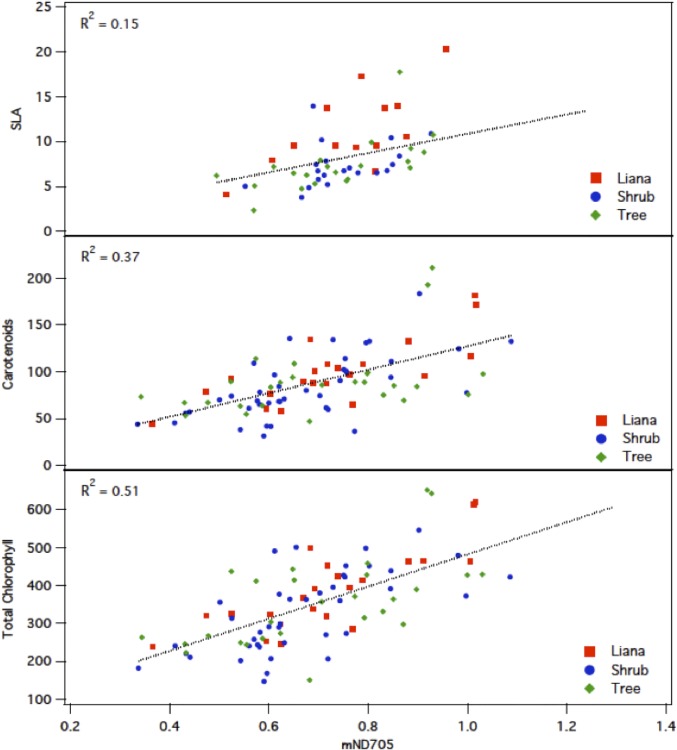
Relationships between and modified NDVI at 705nm (mND705) and Specific Leaf Area (SLA), Carotenoids and Total Chlorophyll concentration for Lianas, Trees and Shrubs.